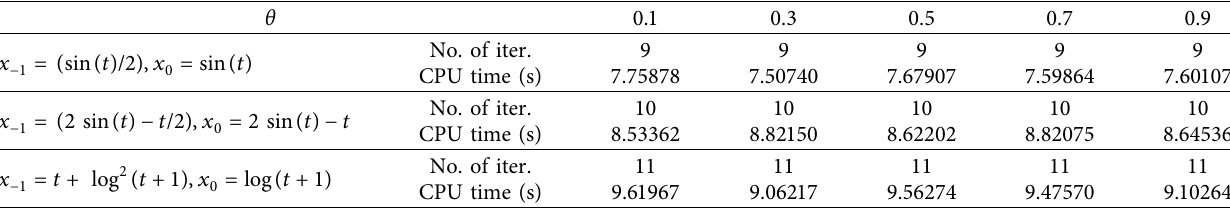
Table 2: Numerical results of the difference θ .